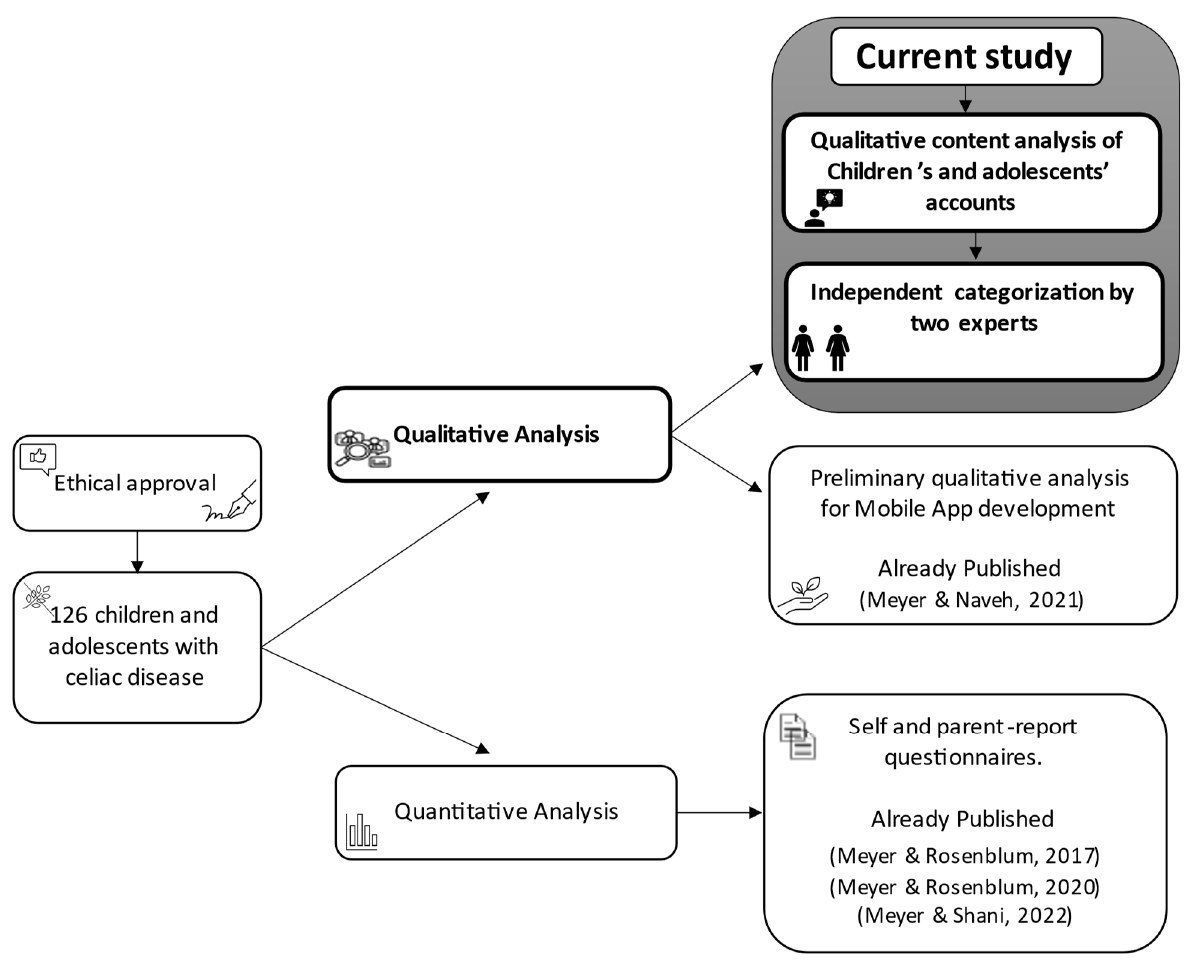
Figure 1. Methodology flowchart.